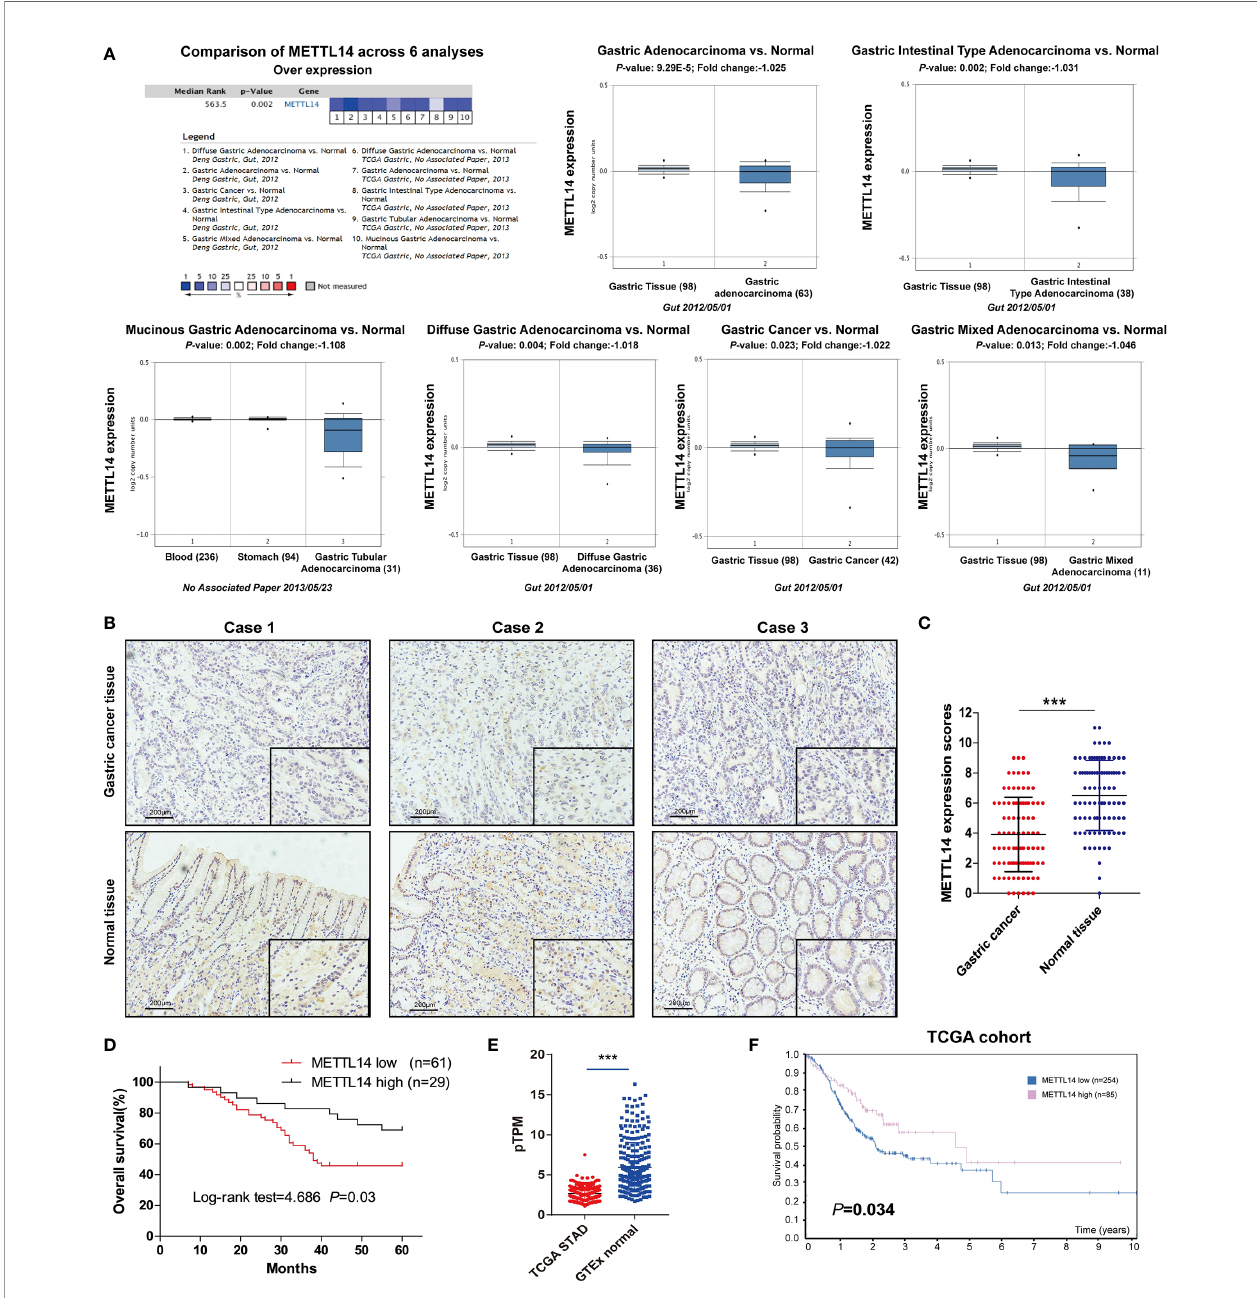
FIGURE 1 | Downregulated METTL14 correlated with poor prognosis in STAD. (A) Expression level of METTL14 were analyzed by Oncomine database; (B) Representative pictures of immunohistochemical results of METTL14 in STAD and normal tissue. (C) Comparision of METTL14 in STAD tissue with normal gastric tissue (n = 90) (*** P < 0.001). (D) Overall survival comparison between METTL14 high and low expression in STAD patient. (E) Comparison METTL14 mRNA expression levels between TCGA STAD and GTEx stomach normal tissue (*** P < 0.001). (F) Prognostic value of METTL14 mRNA expression in STAD of TCGA